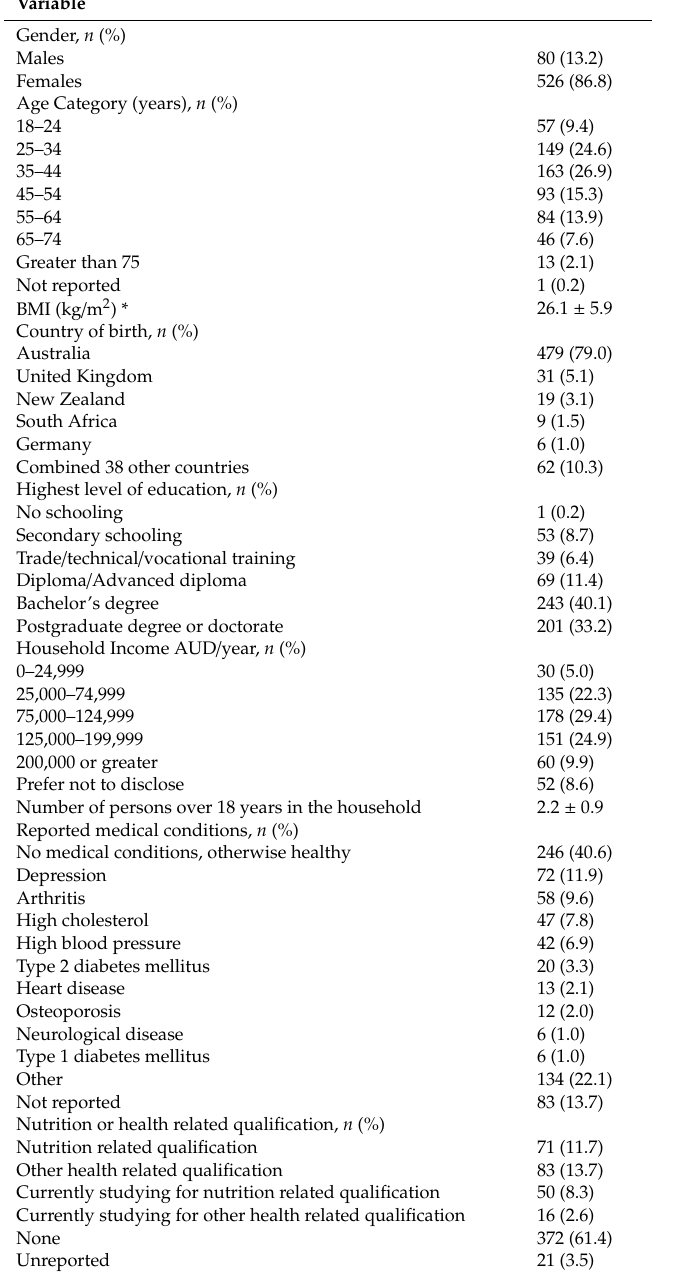
Table 2. Demographic characteristics of survey participants ( n =